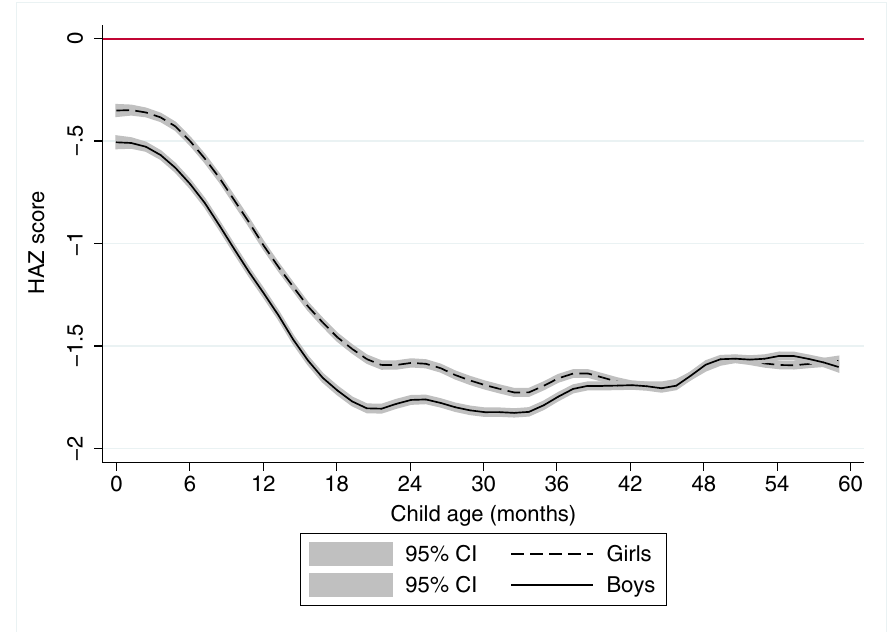
Fig 1. A local polynomial regression plot of height-for-age z score against child age for 699,421 children aged 0–57 months in 58 countries. Notes: The graph is based on local polynomial smoothing estimates of HAZ scores against child age for 699,421 children from 125 Demographic Health Surveys for 57 countries. 95% confidence intervals (CI) are reported in grey shading.